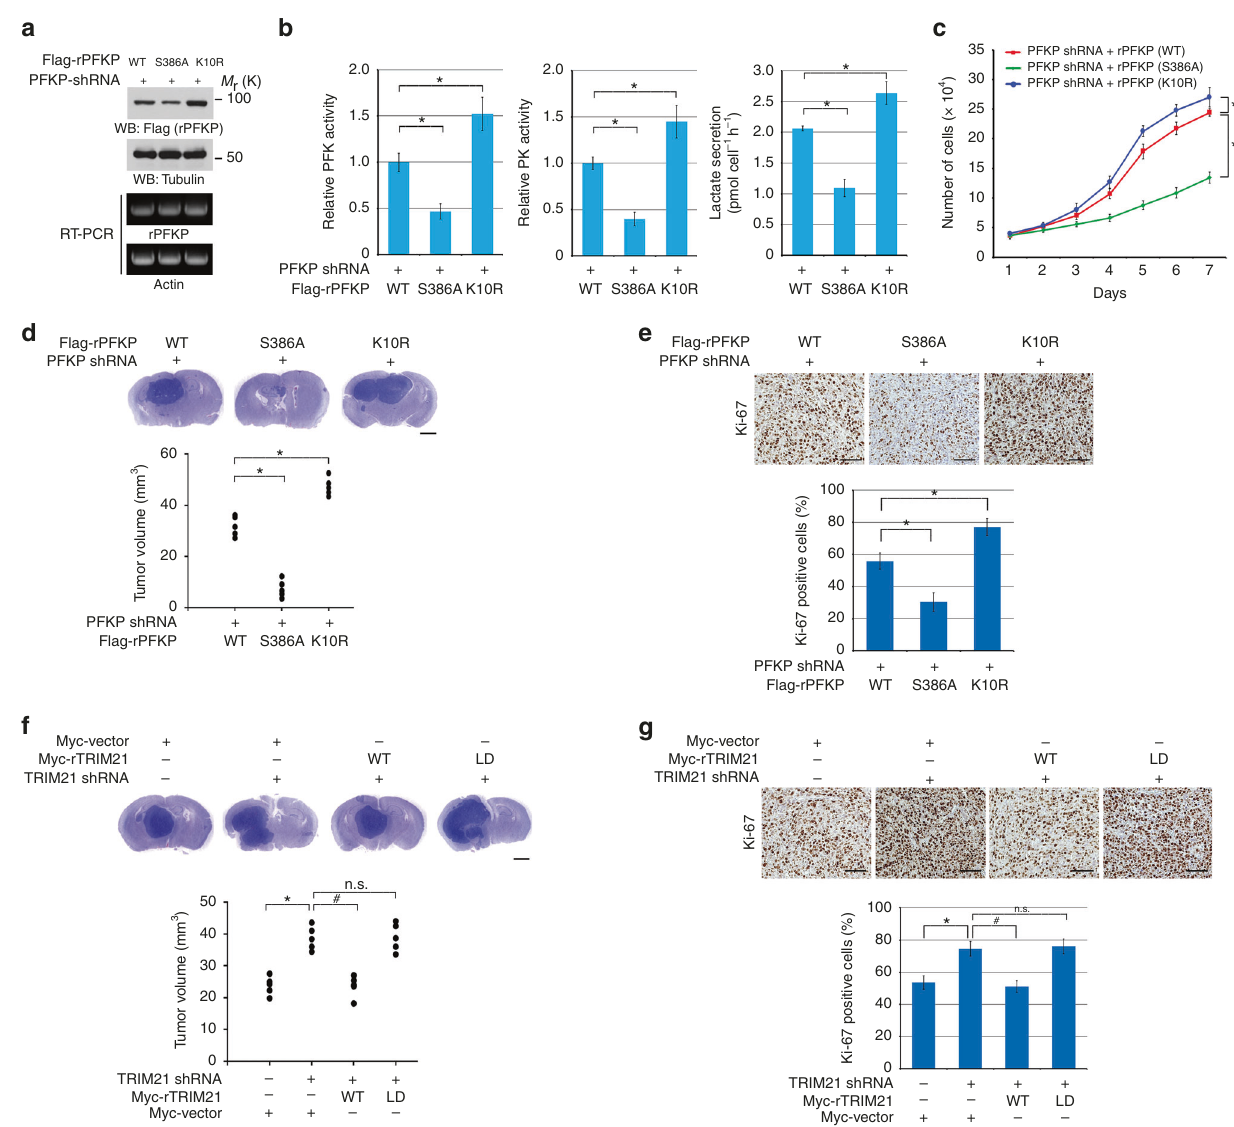
Fig. 6 PFKP S386 phosphorylation promotes glycolysis and tumor growth. a PFKP-depleted U87/EGFRvIII cells were reconstituted with the indicated protein expression. Immunoblotting analyses were performed with the indicated antibodies (top panel). RT-PCR was performed with the indicated primers to show relatively equal expression of the indicated mRNAs (bottom panel). b , c PFKP-depleted U87/EGFRvIII cells with reconstituted expression of the indicated proteins were cultured in non-serum DMEM for 24 h ( b ) or in 1% serum medium for the indicated periods of time and harvested for cell counting ( c ). The cells and the media were collected to analyze glucose consumption, PFK activity, PK activity, or lactate secretion. All results were normalized to the fi nal cell number ( b ). Data represent the means ± s.d. of three independent experiments. * P < 0.001, based on the Student ’ s t test. d A total of 5 × 10 5 PFKP-depleted U87/EGFRvIII cells with reconstituted expression of the indicated proteins ( d ) or U87/EGFRvIII cells with or without TRIM21 depletion and reconstituted expression of WT Myc-rTRIM21 or Myc-rTRIM21 LD ( f ) was intracranially injected into athymic nude mice. After 2 weeks, the mice were euthanized and examined for tumor growth. Hematoxylin-and-eosin-stained coronal brain sections show representative tumor xenografts (top panel). Tumor volumes were measured by using length ( a ) and width ( b ) and calculated using the equation V = ab 2 /2. Data represent the means ± s.d. of 5 mice (bottom panel). * P < 0.001, based on the Student ’ s t -test d . * P < 0.001, # P < 0.001, based on the one-way ANOVA; n.s., not signi fi cant f . Note that the scores of some samples overlap. Scale bar, 2 mm. e IHC analyses of the tumor tissues were performed with an anti-Ki-67 antibody. Representative staining (top panel) and quanti fi cation of the staining (bottom panel) are shown. * P < 0.001, based on the Student ’ s t test. Scale bar, 100 μ m. g IHC analyses of the tumor tissues were performed with an anti-Ki-67 antibody. Representative staining (top panel) and quanti fi cation of the staining (bottom panel) are shown. * P < 0.001, # P < 0.001, based on the one-way ANOVA. Scale bar, 100 μ PTEN function are frequently observed in human cancers. PTEN expression levels were inversely correlated with AKT S473 phosphorylation and PFKP S386 phosphorylation and expression levels, highlighting the importance of the effect of loss of PTEN function on PFKP expression and aerobic glycolysis. These fi ndings underscore the potential of PFKP as a molecular target for the treatment of human cancer. and purify the PFKP pS386 antibody. The PFKP pS386 antibody was then eluted